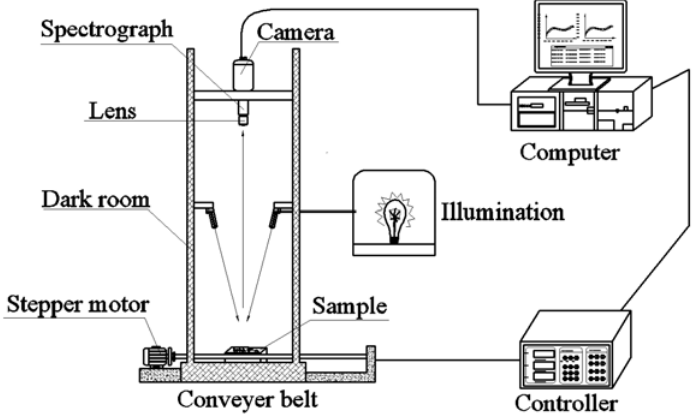
Figure 1. Hyperspectral imaging